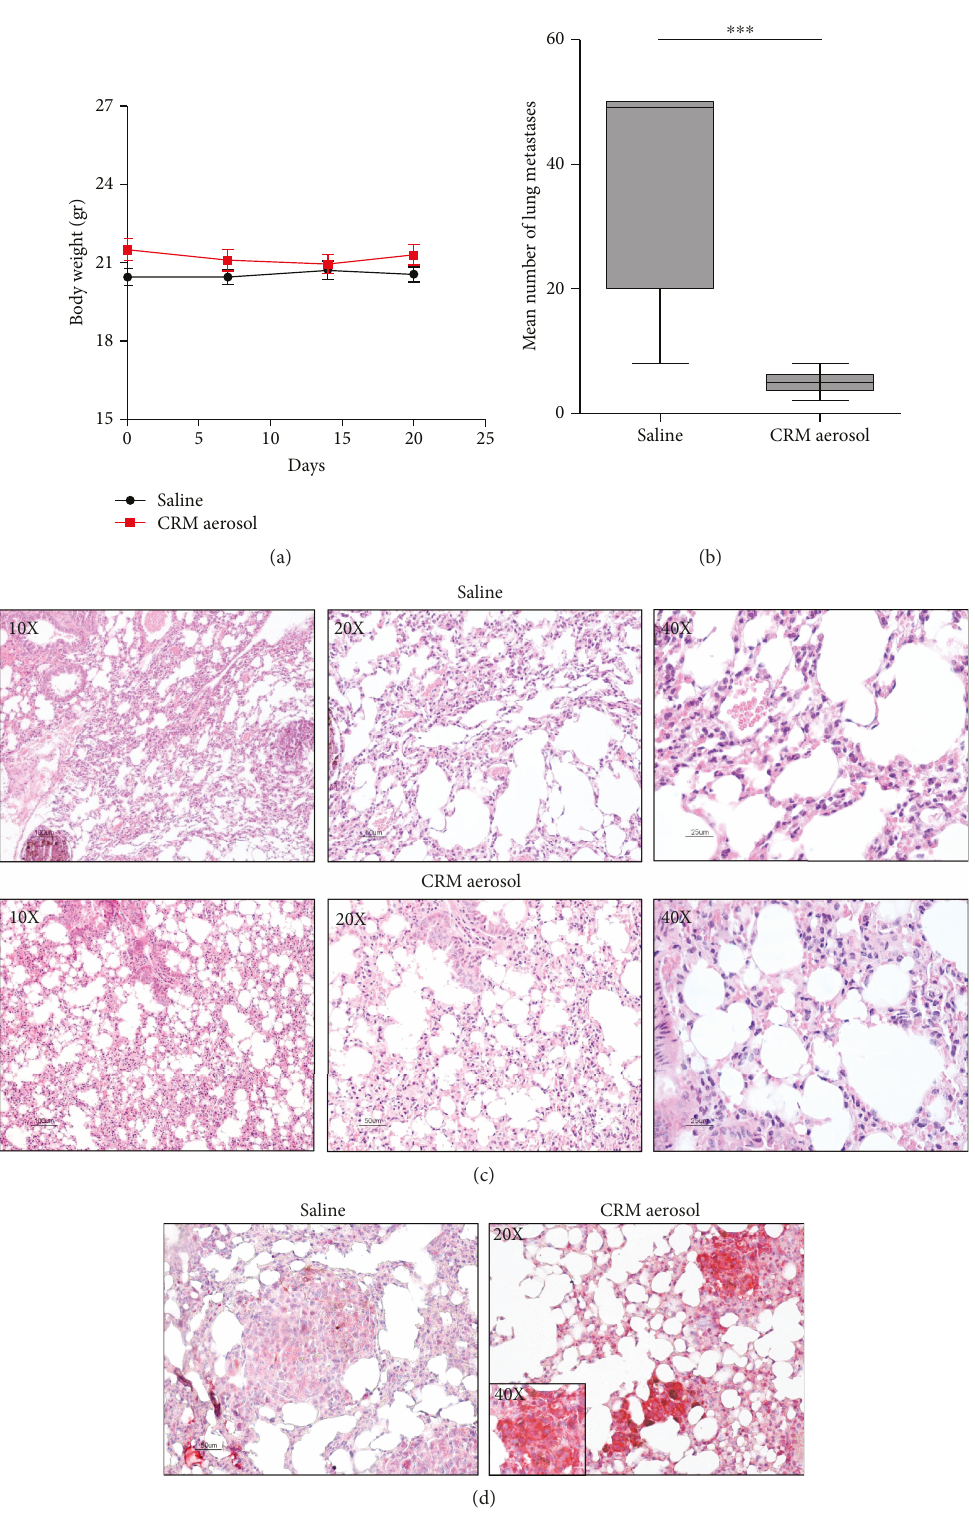
Figure 1: E ff ects of CRM aerosolization on body weight, on the growth of experimental B16 lung metastases, and on lung histology. Body weights (a) and number of macroscopic lung metastatic foci (b) of mice (9-10 mice/group) treated starting 1 day after i.v. injection of B16 melanoma cells with aerosolized saline or combined CRMs for 3 weeks. Representative images showing histopathological evaluation of hematoxylin- and eosin-stained lung tissue sections (c) and IHC analysis of LC3B staining in tumor nodules (d) (magni fi cation: × 200) of saline and CRM-treated mice. ∗∗∗ p ≤ 0 001 by Student ’ s t